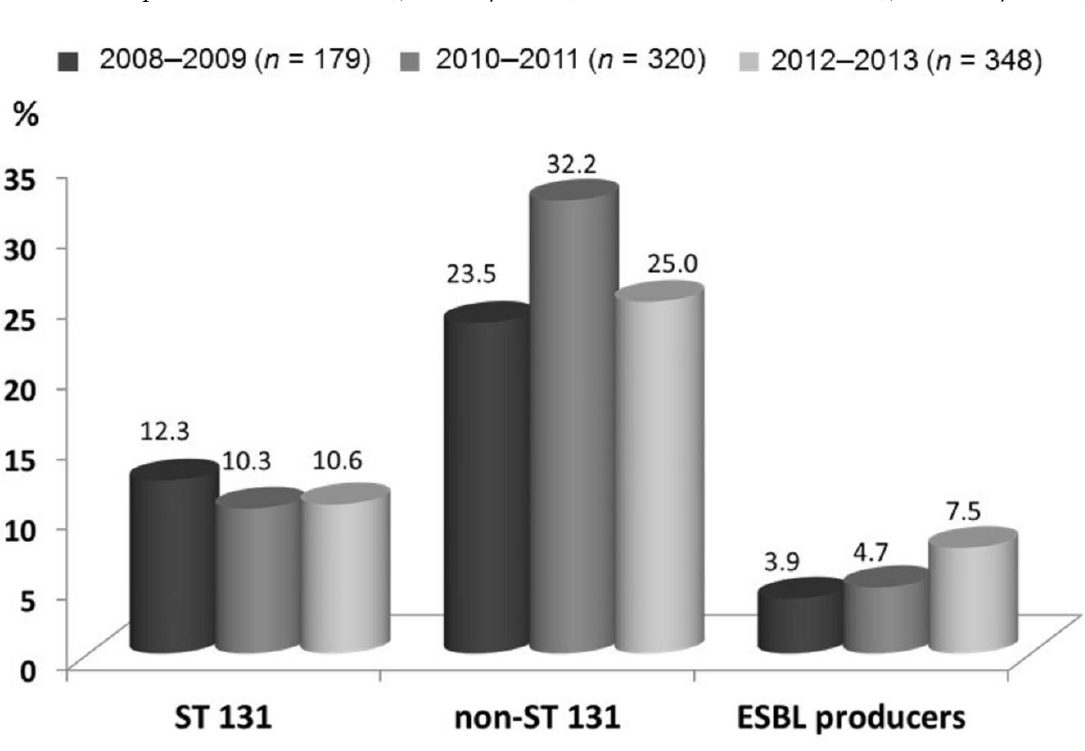
Figure 1. Proportions of sequence type (ST) 131 and non-ST131 clones and extended-spectrum β-lactamase (ESBL) producers in community-onset Escherichia coli bacteremia in three periods from 2008 to 2013. An annual increasing trend in ESBL producers was observed ( γ = 1.00, p = 0.01).